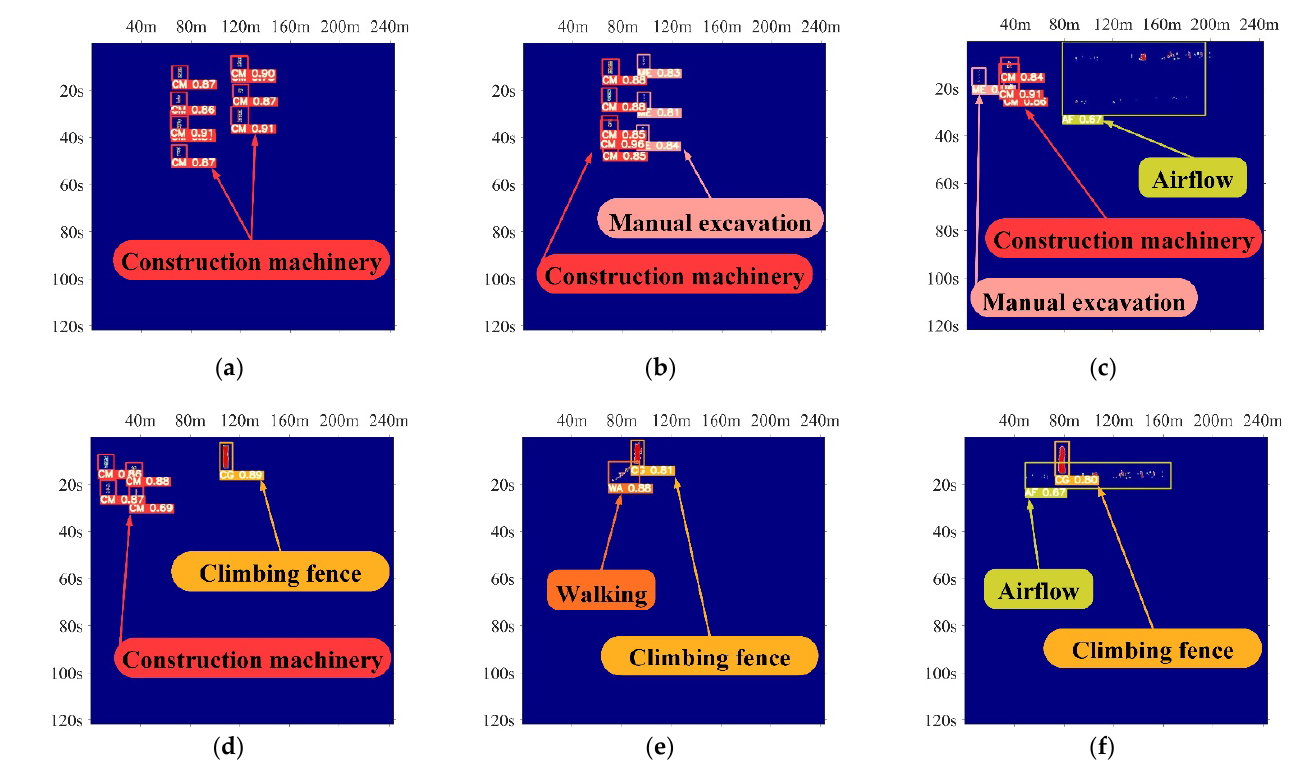
Figure 10. Effectiveness of six different mixed vibration events identification: ( a ) Multiple construc- tion machines; ( b ) Multiple construction machines and manual excavation; ( c ) Airflow interference exists nearby the buried fiber optic site where the early warning activities occurred; ( d ) Climbing over the fence behavior and construction machinery activities occur in the same monitoring area; ( e ) People walking in the buried fiber optic area and climbing over the fence; ( f ) Person climbing over the fence during airflow interference.